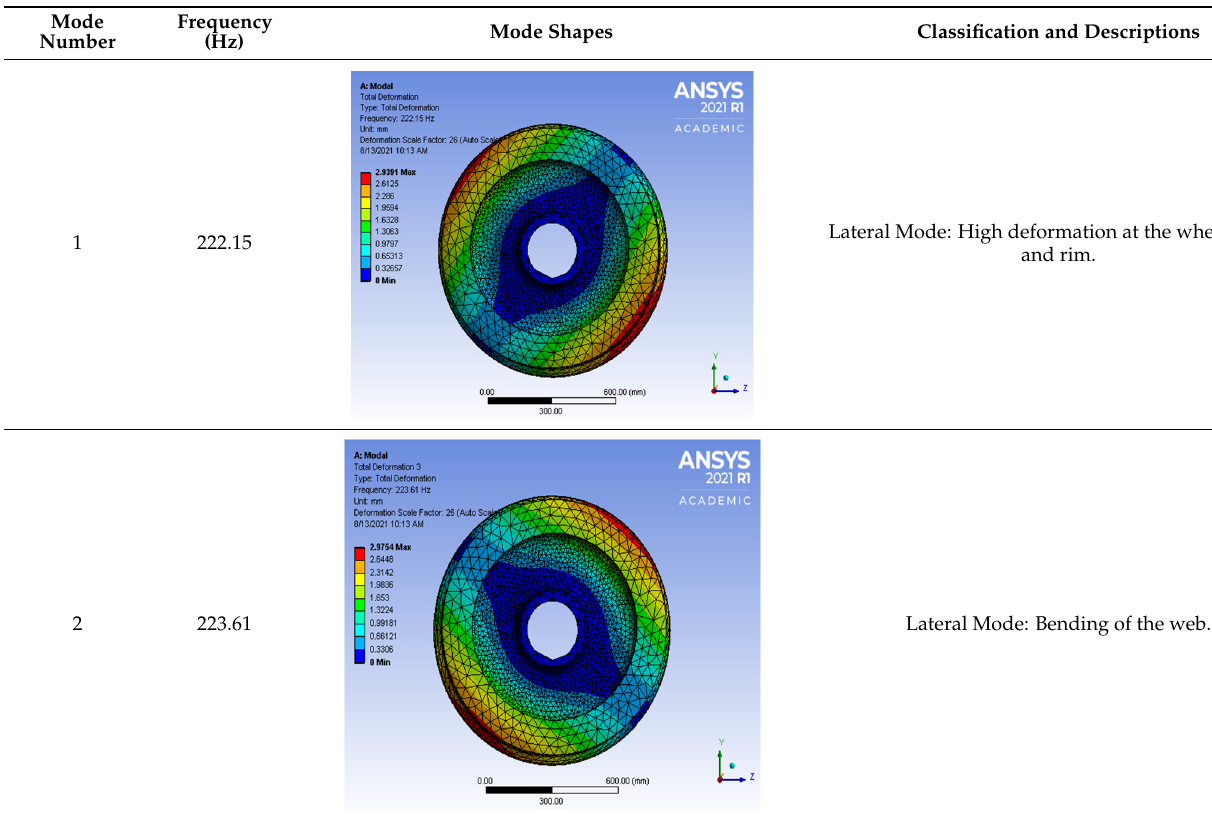
Table 7. First natural frequencies of the wheel.